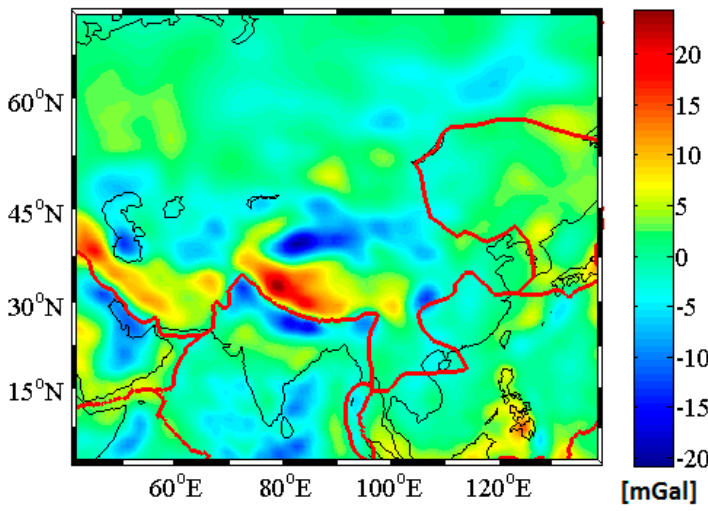
Figure 4. Estimated values of the parameter W .